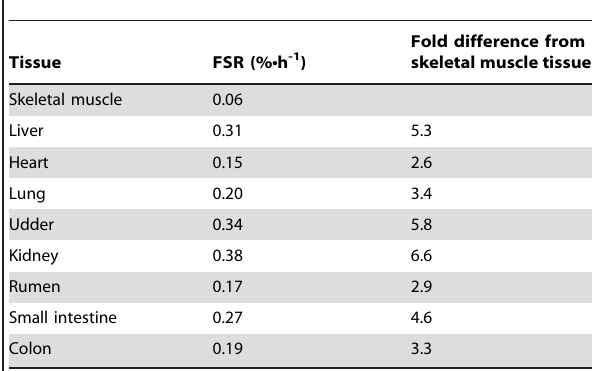
Table 1. Estimates of fractional synthesis rates (FSR) of tissue proteins and the fold difference from skeletal muscle tissue in a lactating dairy